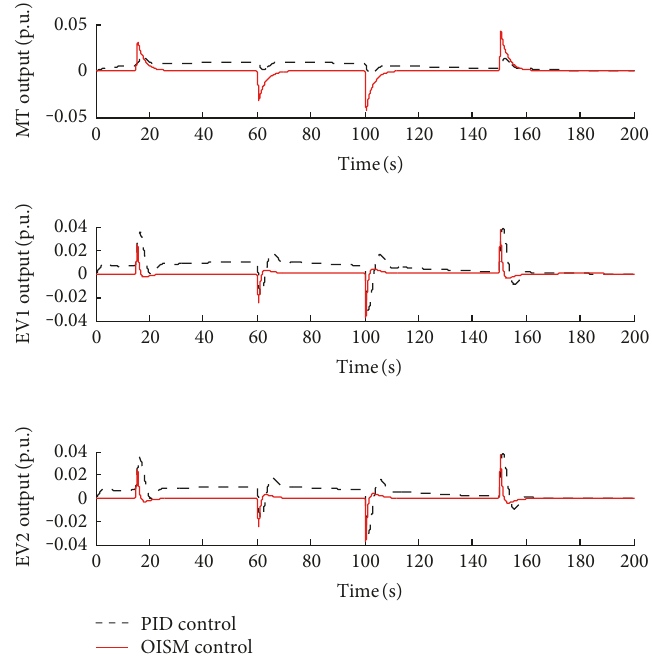
Figure 10: The output power of MT and EVs without power output constraints.